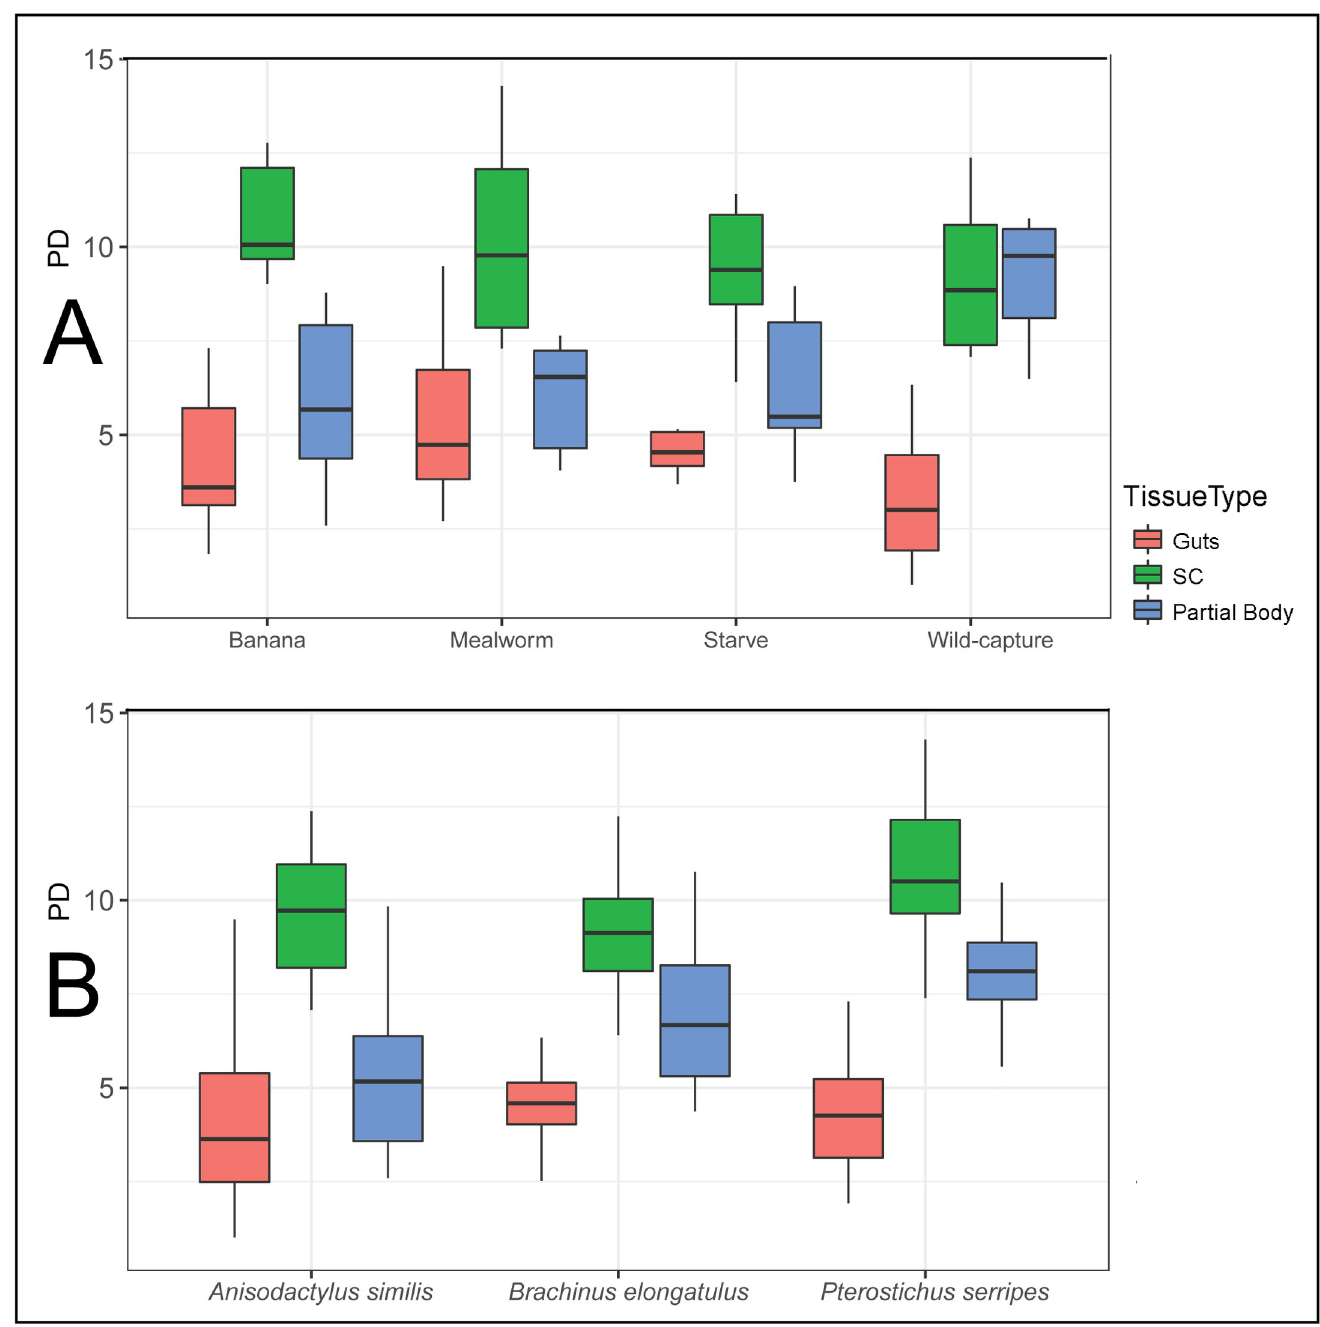
Fig 1. Boxplots of Phylogenetic Diversity (PD), with outliers depicted as points. (A) Plots grouped by diet treatment. PD of partial bodies varied significantly by diet treatment (H = 8.96, p = 0.030), but PD of all other tissues and of aggregate communities did not. (B) Plots grouped by host species. PD of partial bodies varied significantly by host species (Kruskal Wallis H = 8.11, p = 0.017), but PD of all other tissues and of aggregate communities did